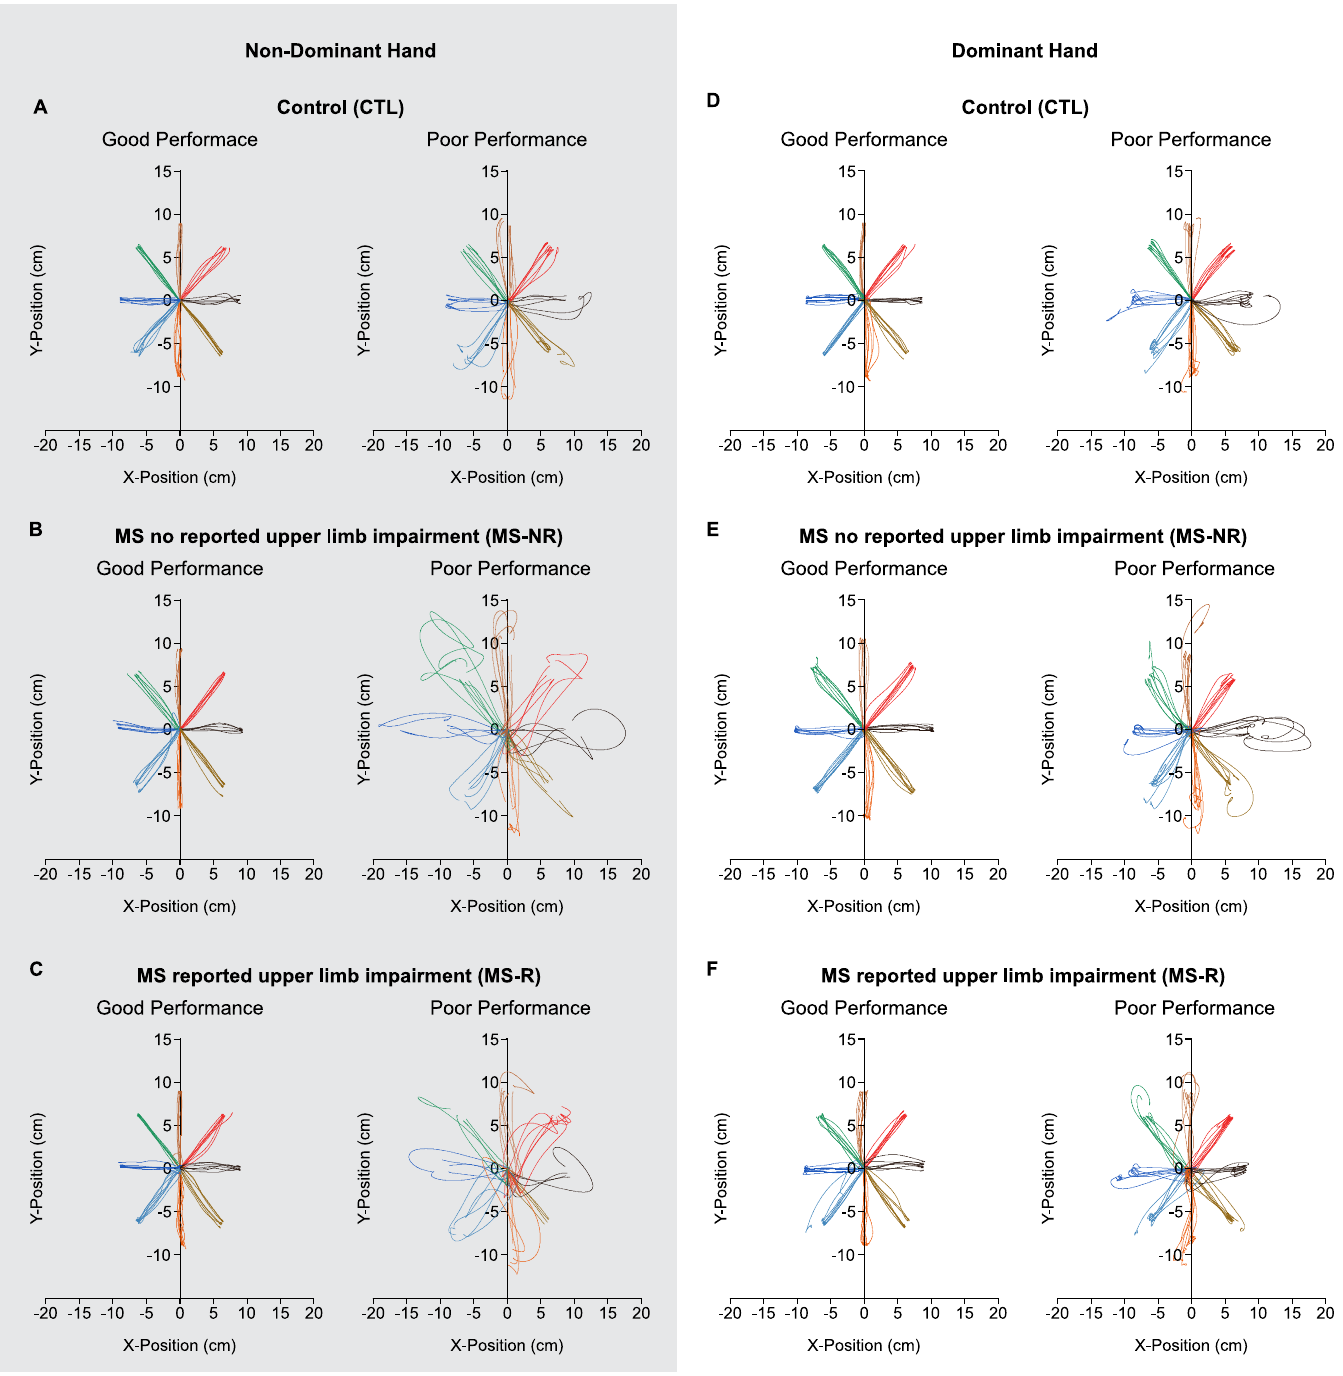
Fig 2. Sample reaching trajectories. Reaches completed to the 8 visual targets with the non-dominant (shaded area) and dominant hands. Each colour represents a reach trajectory to one of the 8 targets. Performance were classified as “Good” versus “Poor” based on their average path length (i.e., Good performance was represented as shorter path lengths versus Poor performance was represented as longer path